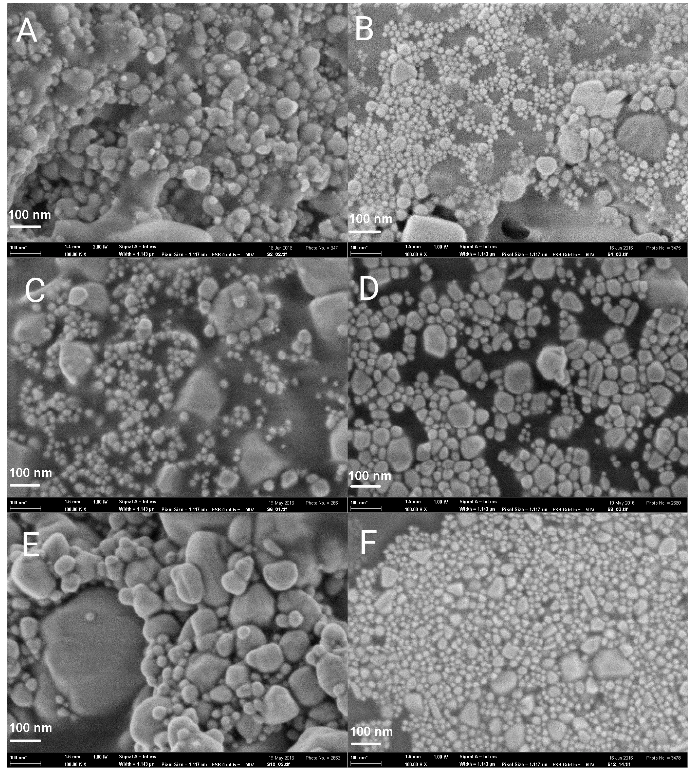
Figure 8. SEM images of Ag/12- s -12 nanoparticles. ( A ): s = 2, ( B ): s = 4, ( C ): s = 6, ( D ): s = 8, ( E ): s = 10, ( F ): s = 12.